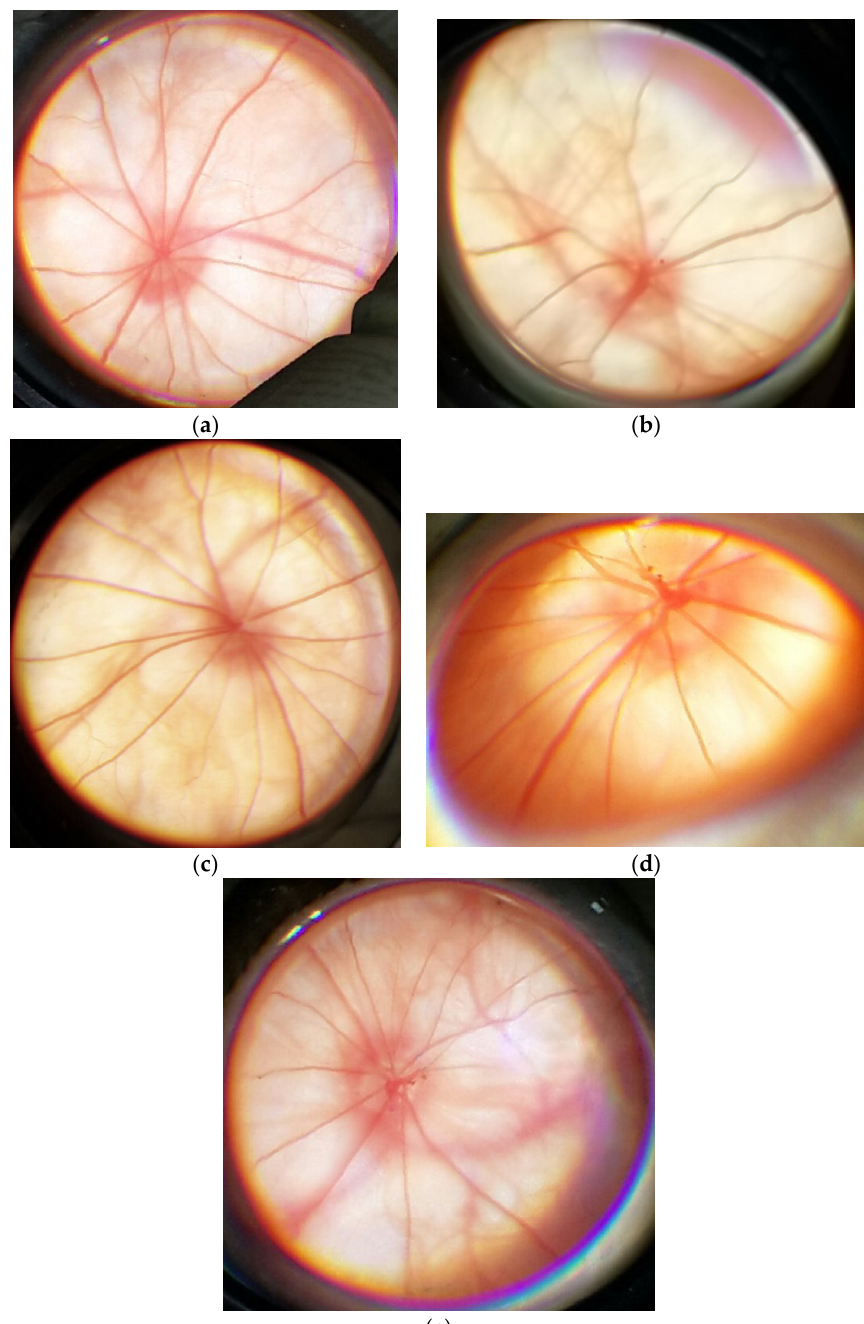
Figure 2. Eye fundus images from rats: ( a ) From the control group; ( b ) with the simulated retinal ischemia–reperfusion; ( c ) with the administration of 2-ethyl-3-hydroxy-6-methylpyridine nicotinate; ( d ) with the administration of nicotinic acid; ( e ) with the administration of Emoxipine.